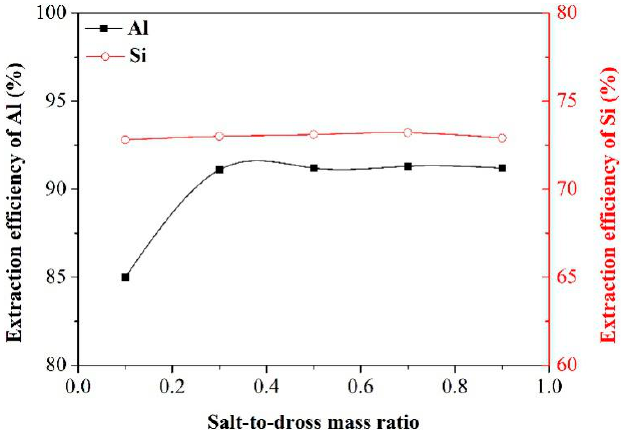
Figure 6. Effect of salt-to-dross mass ratio on the extraction efficiency of Al and Si.